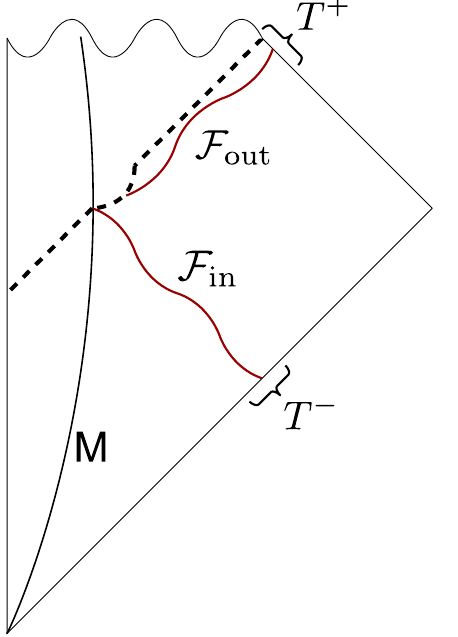
Fig. 3 A Goldstone supertranslation on a black hole of mass M . First, it absorbs radiation with angular distribution F in and then it evapo- rates radiation with angular distribution F out . Since d u d 2 (cid:4) F out , the total energy of the black hole remains unchanged. Here F in can be described in terms of the supertranslation T − and F out in terms of T